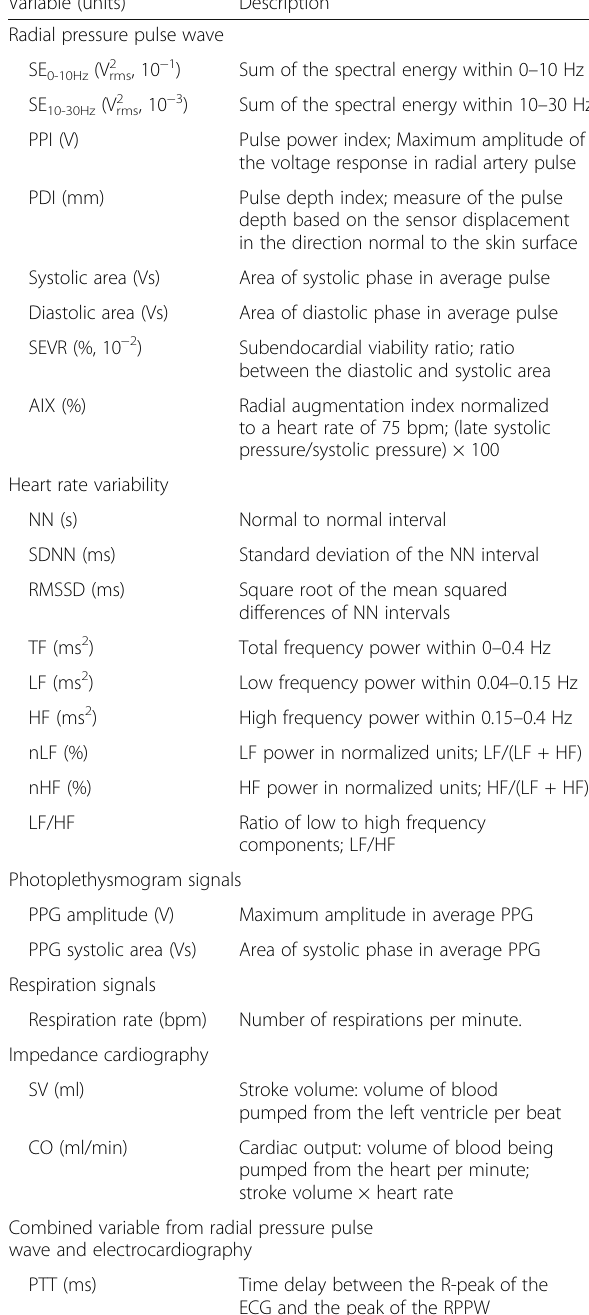
Table 1 Description of parameters related with the radial artery pulse-pressure wave and other bio-signal